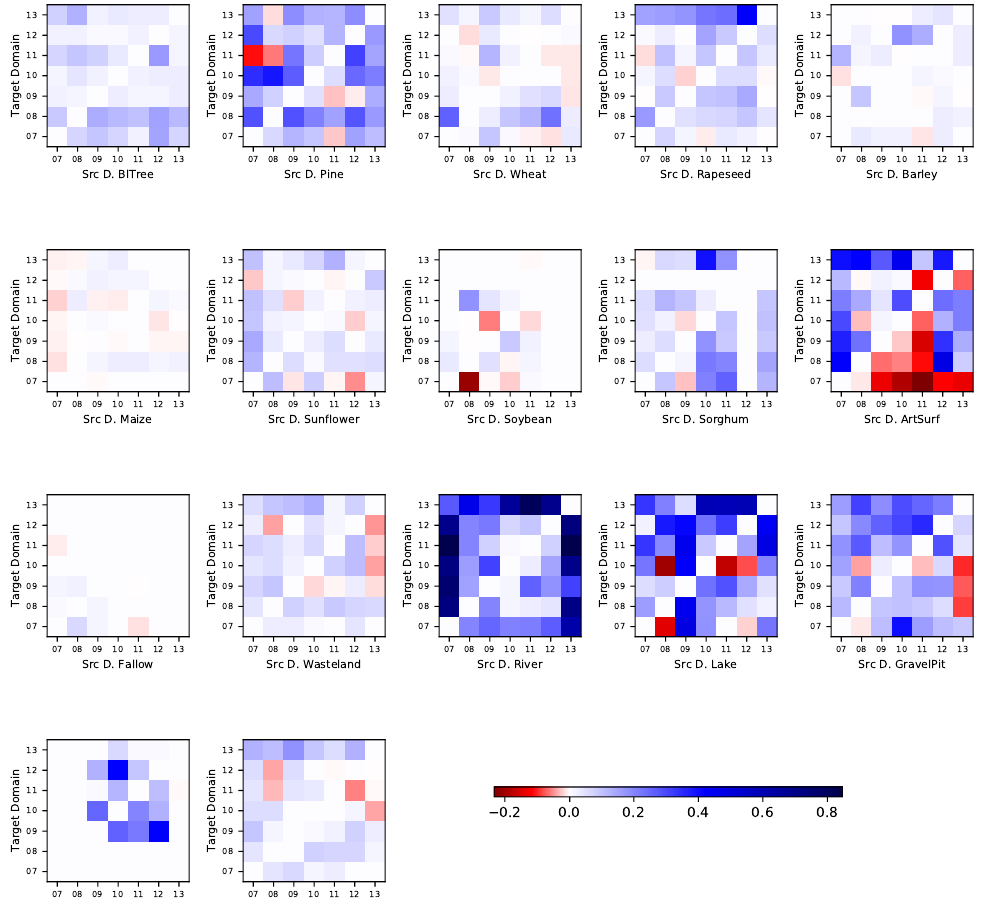
Figure 7. FScore difference between the naive case and PAS-EMD transport estimation. Each plot corresponds to a class for each pair of years available. The diagonals are empty. The source domain year and class is indicated on the x-axis, the target domain year on the y-axis. The color scale shows the difference range. Red hues represent a decrease in FScore and blues hues an